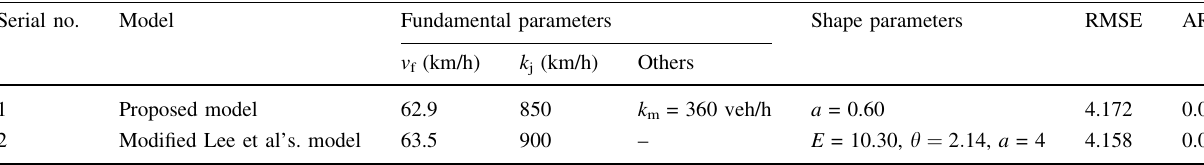
Table 7 Parameters and estimation accuracy of proposed models Serial